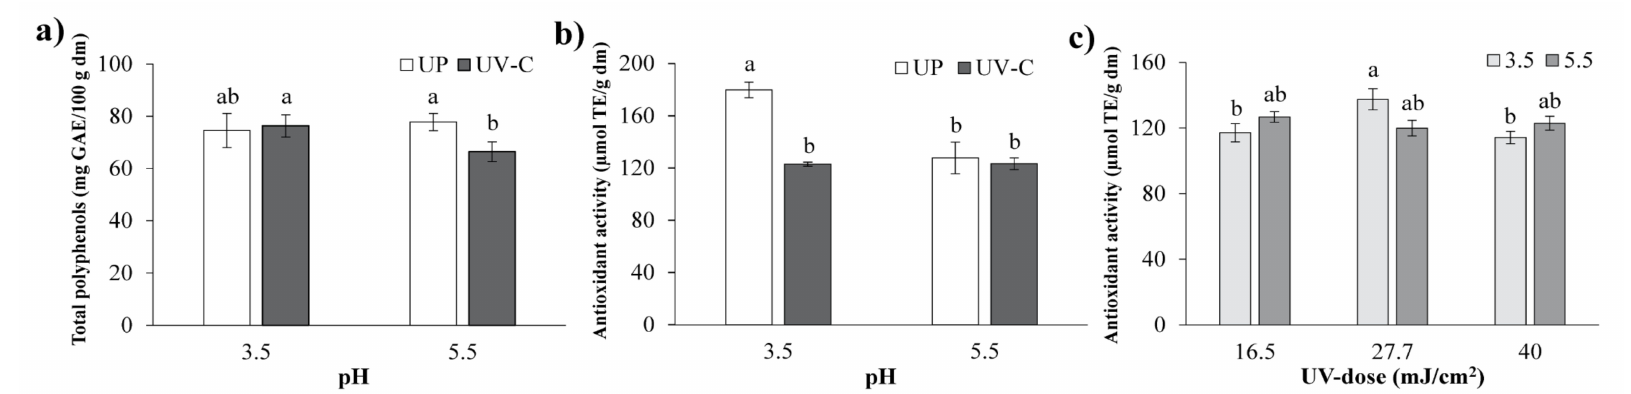
Figure 5. Total polyphenols and total antioxidant activity of the Aloe vera –pitaya blend. ( a ) E ff ect of pH on total polyphenol content in unprocessed (UP) and UV-C irradiated treatments. ( b ) E ff ect of pH on total antioxidant activity in unprocessed (UP) and UV-C irradiated treatments. ( c ) E ff ect of pH at di ff erent UV-C doses on total antioxidant activity. For each figure panel, the di ff erent letters indicate significant di ff erences between the treatments at p <